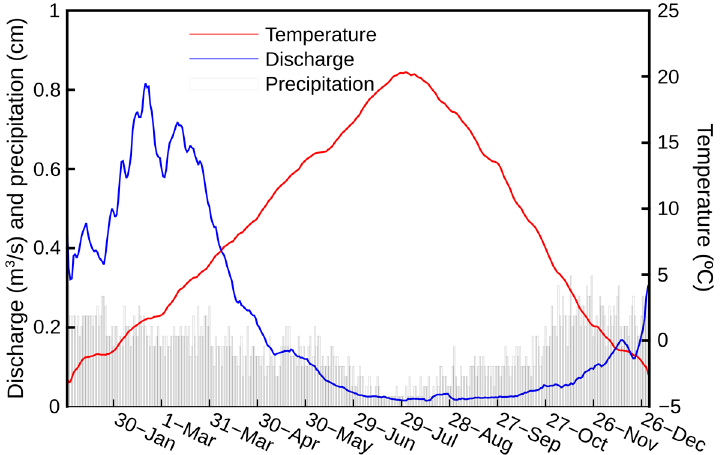
Figure 5. Composited annual streamflow (1979–2020), precipitation (1981–2010), and temperature (1981–2010) for Moscow, Idaho (data from U.S. Geological Survey streamgage at Paradise Creek (3346800) and Western Regional Climate Center climate summary of Moscow, Idaho).